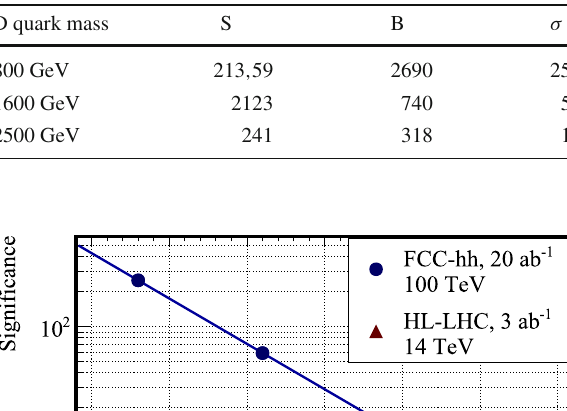
Table 5 Signal and background yields and significance for different D quark masses at FCC-hh